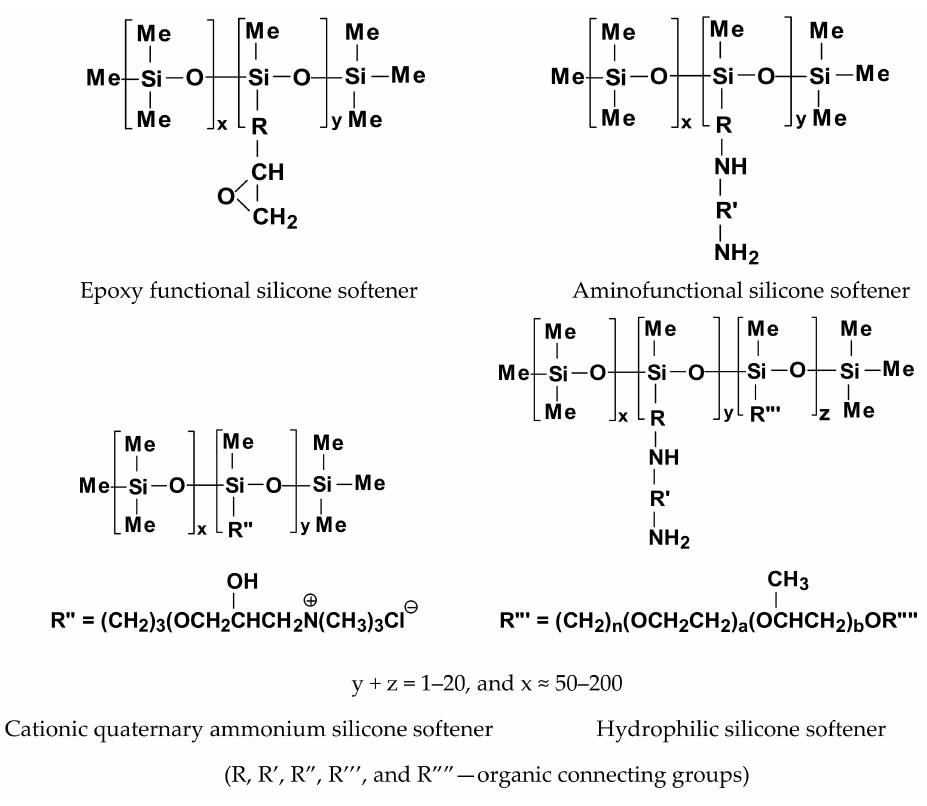
Figure 4. Examples of chemical structures of typical silicone softeners used in the textile